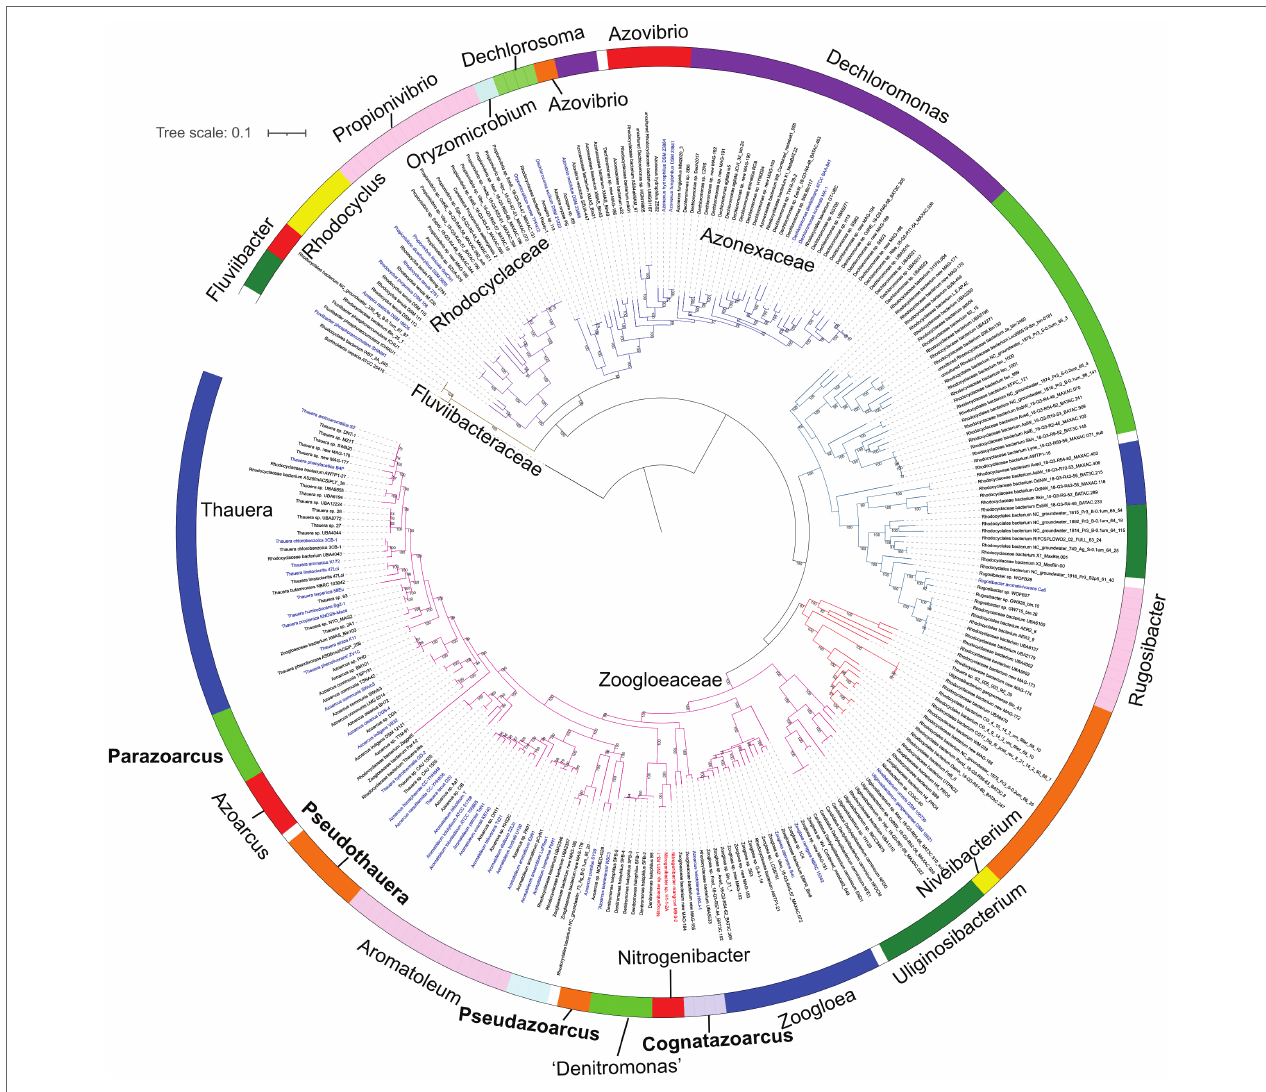
FIGURE 2 | Phylogenomic analysis based on 120 bacterial covered single-copied gene sets of the members affiliated to the order Rhodocyclales using FastTree. The bootstrap values on the node are displayed by >70. Bar, 0.1 represents the nucleotide substitutions per position. The blue names represent validly published species. Red names showed Nitrogeniibacter members. The genus names were shown around the color circle. Four genera proposed in this study are marked